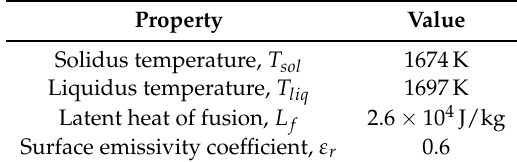
Table 3. Constant thermal properties of 316L stainless steel [57,58].